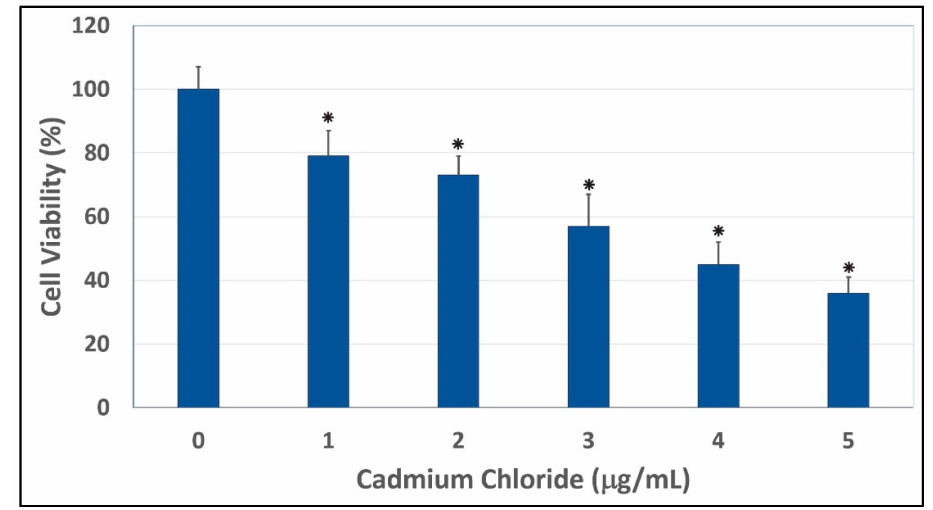
Figure 1. Cytotoxic effect of cadmium chloride on human liver carcinoma (HepG 2 ) cells. Cells were cultured with increasing concentrations (1, 2, 3, 4, and 5 µ g/mL) of cadmium chloride for 48 h as indicated in the Materials and Methods. Cell viability was determined based on the MTT assay. Each point represents a mean ˘ SD of three experiments with six replicates per concentration. * Significantly different ( p < 0.05) from the control, according to the Dunnett’s